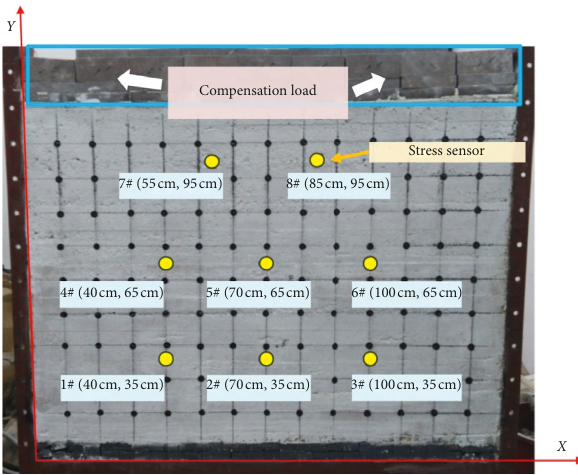
Figure 5: Distribution of measuring